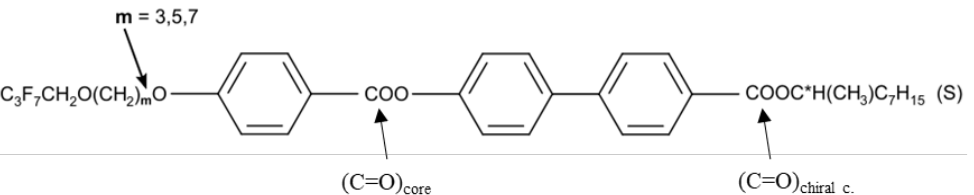
Figure 1. The chemical structure of the 3F m HPhH7 compounds under study. ‘ m ’ is the number of methylene groups in the non-chiral terminal chain, ‘ m ’ = 3, 5 or 7. (C=O) core is the carbonyl group between the biphenyl part and the phenyl ring in the rigid core, (C=O) chiral_c. is the carbonyl group between the biphenyl part and the chiral terminal alkyl chain. The asterisk indicates a chiral carbon atom.